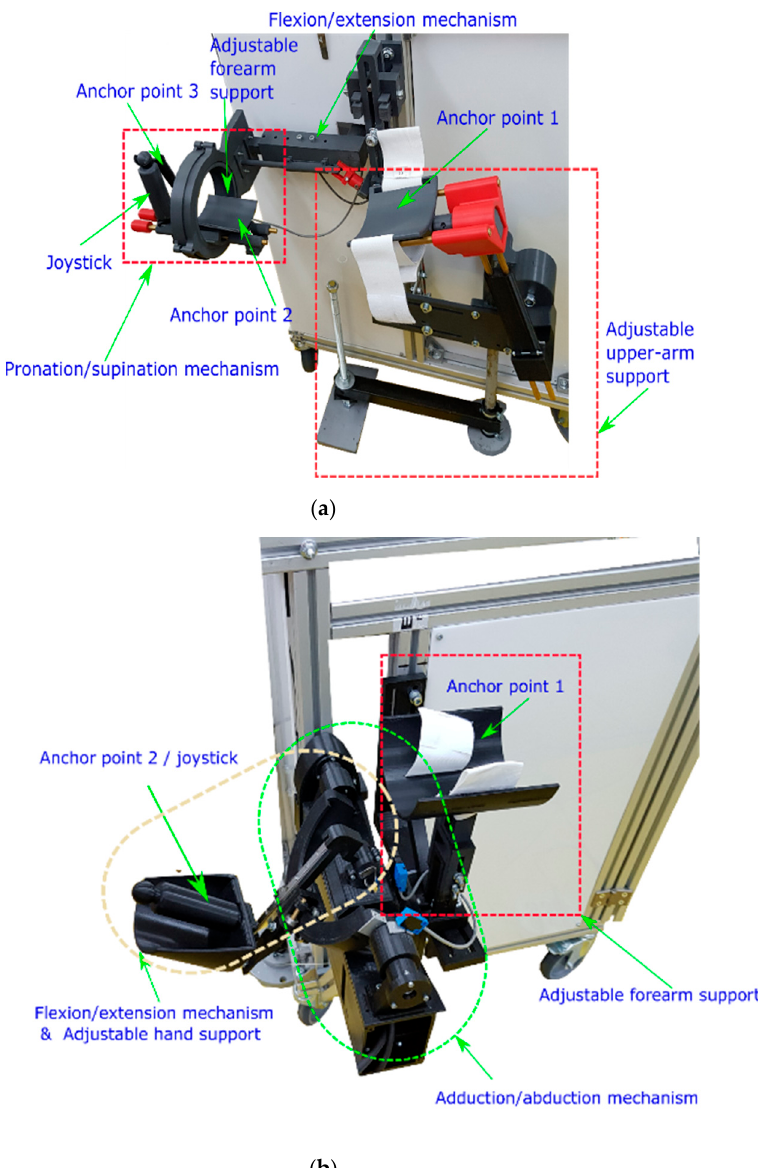
Figure 9. The experimental model of ParReEx robotic system (( a ) elbow rehabilitation module, ( b ) wrist rehabilitation module).